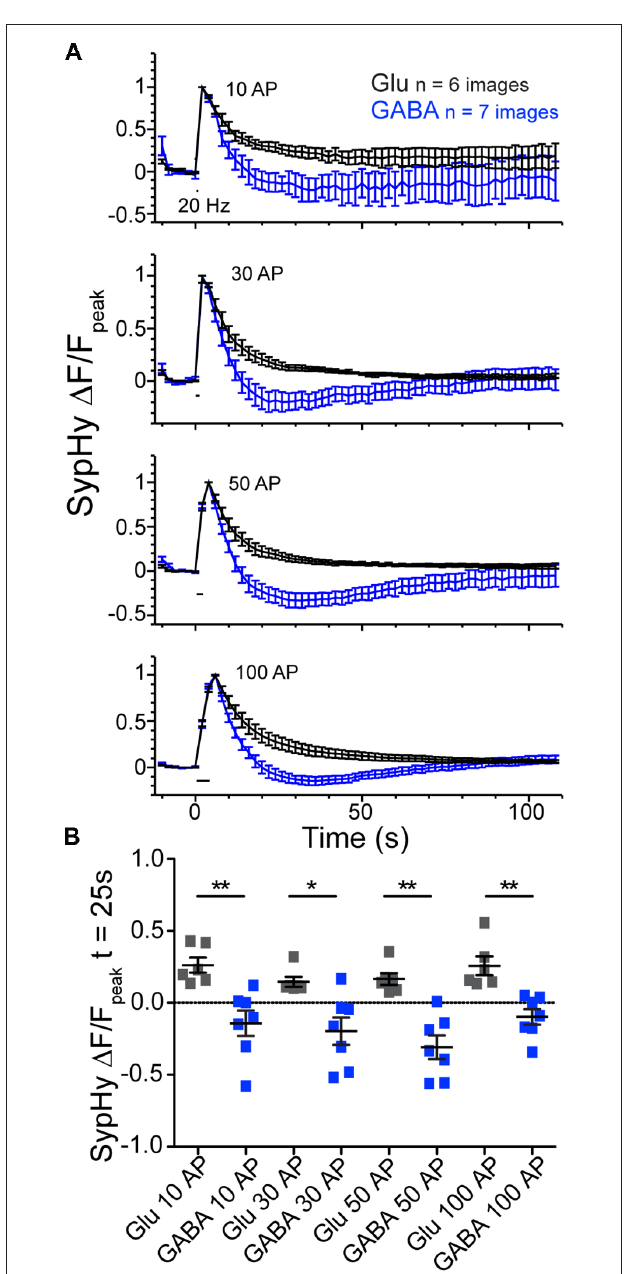
FIGURE 3 | Glutamatergic and GABAergic synaptic vesicles (SVs) display differences in reacidification processes regardless of stimulus number. (A) Average SypHy fluorescence normalized to peak fluorescence after stimulation in glutamatergic (black) or GABAergic (blue) synapses stimulated with 10, 30, 50 and 100 pulses at 20 Hz. Stimulation duration (20 Hz) indicated by black interval bar. Mean ± SEM, three independent cultures. (B) Scatter plot of SypHy fluorescence normalized to the peak fluorescence for each stimulation train at a time point 25 s post stimulation. Bars = Mean ± SEM. Significance determined by Mann Whitney test. 10 AP, ∗∗ p = 0.0012; 30 AP, ∗ p = 0.0221; 50 AP, ∗∗ p = 0.0012; 100 AP, ∗∗ p = 0.0012.